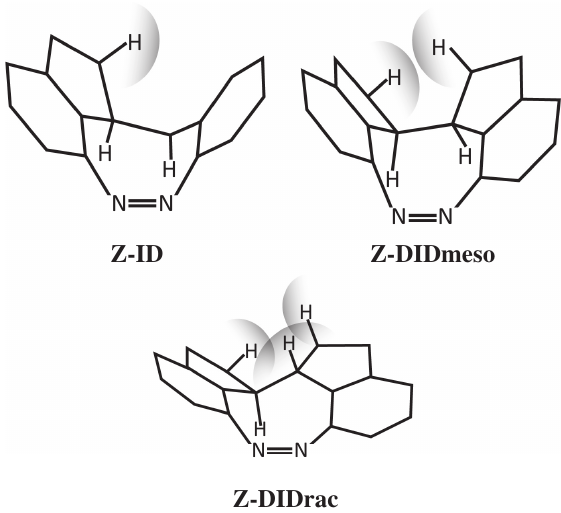
Figure 7. Schematic view of the steric effects of the added ethyl- ene bridges for the Z isomers of the studied compounds. Table 7 shows the averaged values for important DOFs and their change over time during the excited-state dynamics in the same fashion as Table V in Ref. [8] for easier comparison